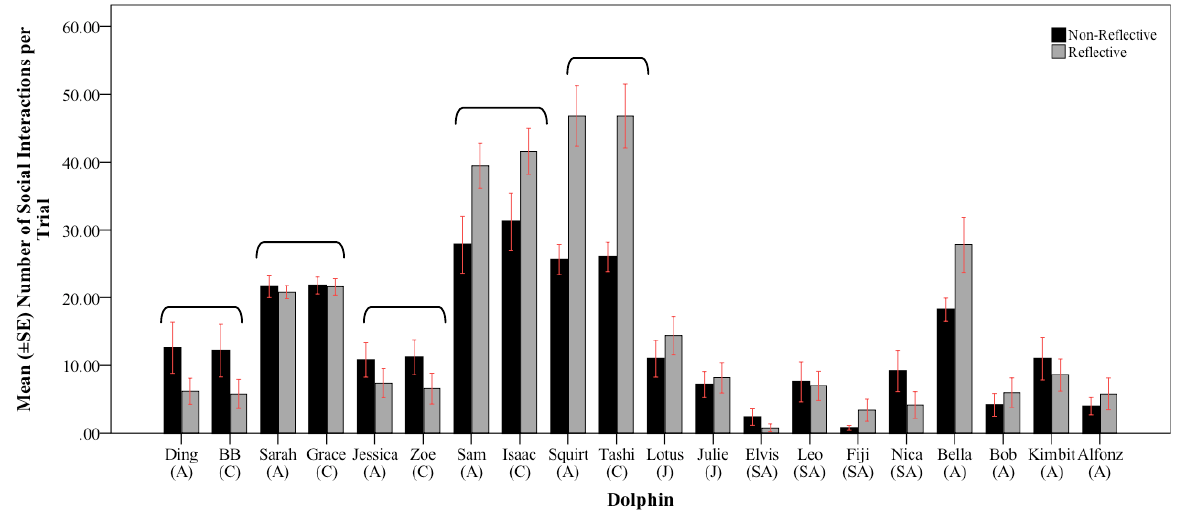
Figure 7. Mean (± 1 SE) number of social interactions exhibited in response to the reflective and non-reflective surfaces of the apparatus for each subject ( N = 30), identified as individuals and their age class: calf (C), juvenile (J), subadult (SA), and adult (A). Brackets delineate mother-calf